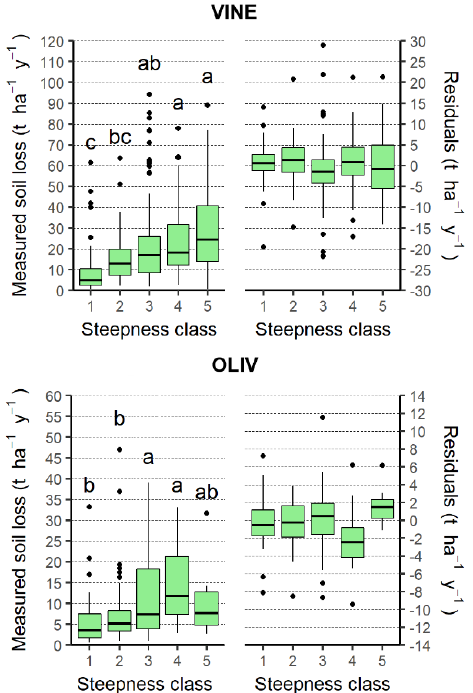
Figure 4. Boxplots show data for vineyard (VINE) and olive orchard (OLIV) land covers. On the left, boxplots represent the average annual measured soil loss for each steepness class. Small letters indicate the significant differences between steepness classes according to Tukey HSD test ( p < 0.05). On the right, boxplots represent the distribution of residuals between simulated and measured average annual soil loss for each steepness class.